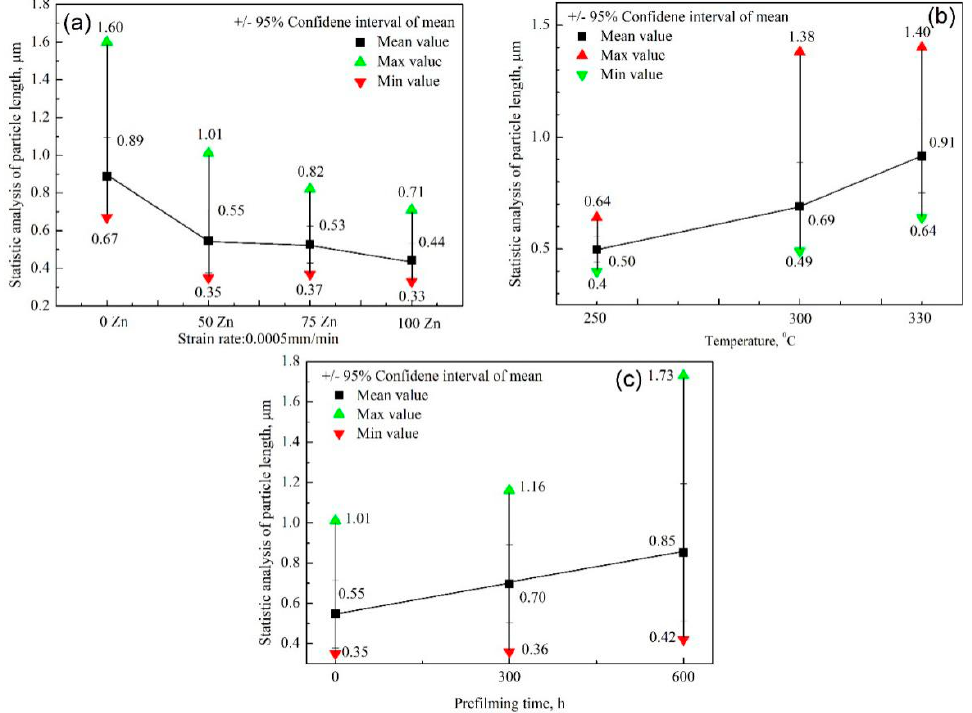
Figure 6. Statistical analysis results of the particles on the sample surface: ( a ) Length vs. Zn content; ( b ) length vs. experiment temperature; and ( c ) length vs. prefilming time.